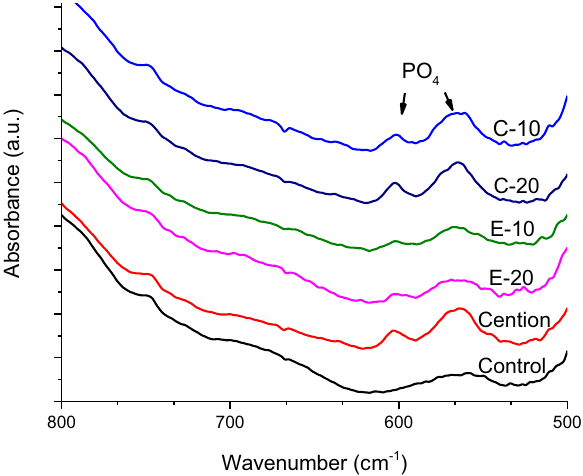
Figure 11. Representative Fourier-transform infrared spectra of specimen surface on which hydroxyapatite precipitate was identified after 32 days lactic acid immersion. The spectral bands at 560 and 600 cm −1 were assigned to bending mode of the phosphate